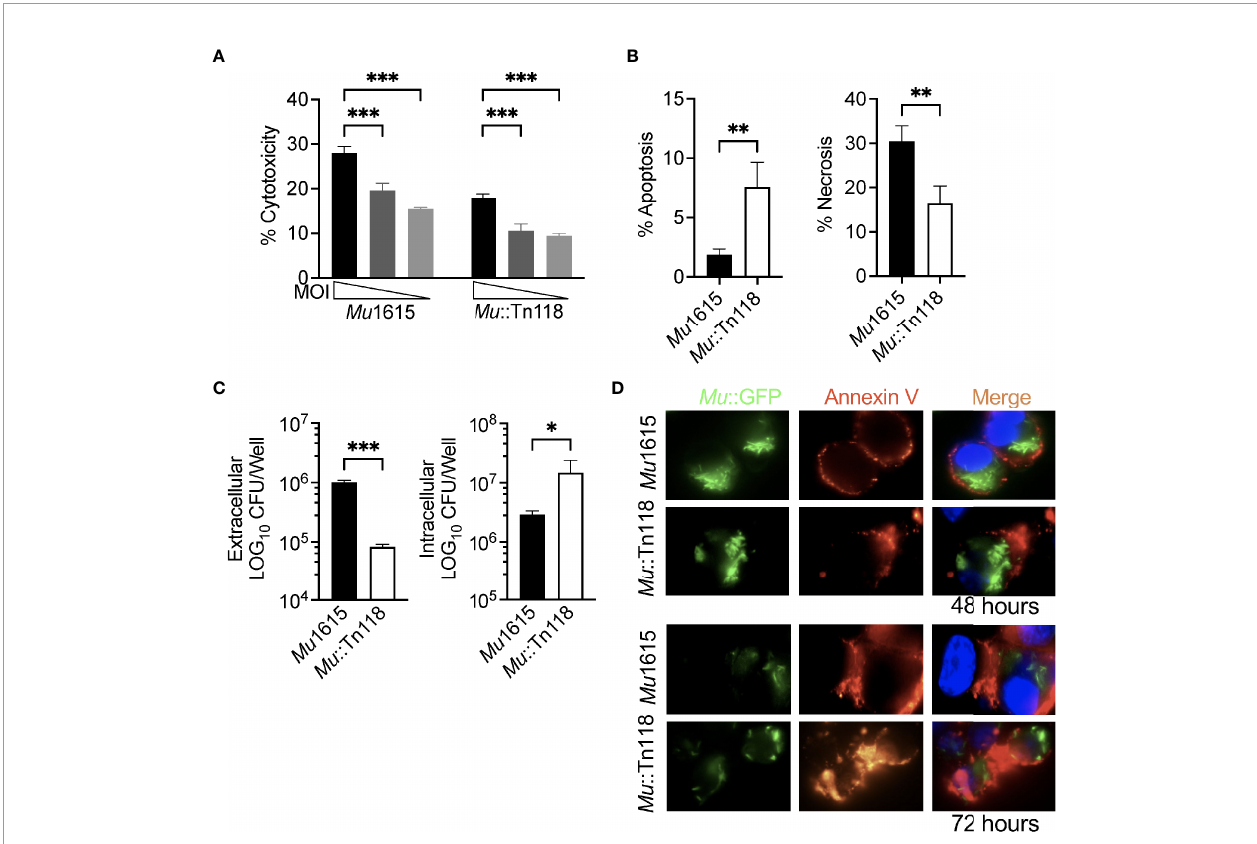
FIGURE 2 | Mycolactone competent Mul induces necrosis leading to bacterial escape. (A) THP-1 monocyte-derived macrophages infected with Mu 1615 or Mu :: Tn118 at MOI 10, 5, and 2 were measured for LDH release at 72 h postinfection. (B) Apoptosis and necrosis were assayed by staining with Annexin-V and 7-AAD in THP-1 monocyte-derived macrophages infected with Mu 1615 or Mu ::Tn118 at MOI 10, 72 h postinfection. (C) THP-1 monocyte-derived macrophage culture supernatant and lysate were plated for CFU enumeration at 72 h postinfection with Mu 1615 and Mu ::Tn118 at MOI 10. (D) THP-1 monocyte-derived macrophages were infected with Mu 1615::GFP or Mu ::Tn118::GFP at MOI 10. At 48 and 72 h, postinfection cells were stained with Annexin-V and visualized by microscopy. Representative images are shown from two independent experiments. Green, Mu::GFP; red, Annexin V; and Blue, DAPI. All graphs represent one of two independent experiments with data expressed as mean ± SD. Signi fi cance was calculated by two-way ANOVA corrected by Bonferroni test for multiple comparisons (A) or T-test (B, C) . *p ≤ 0.05, **p ≤ 0.01, *** ≤ p